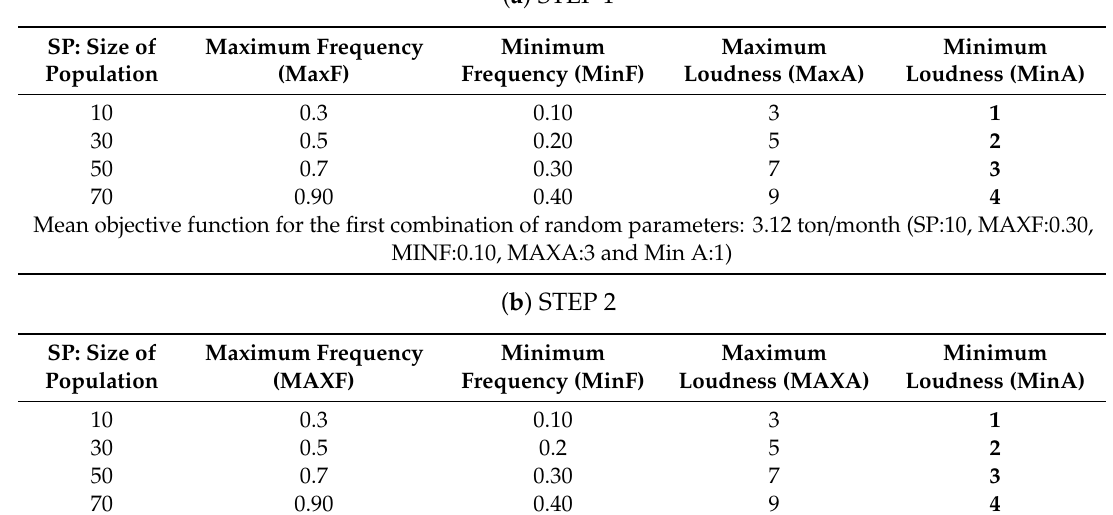
Table 2. A sample of sensitivity